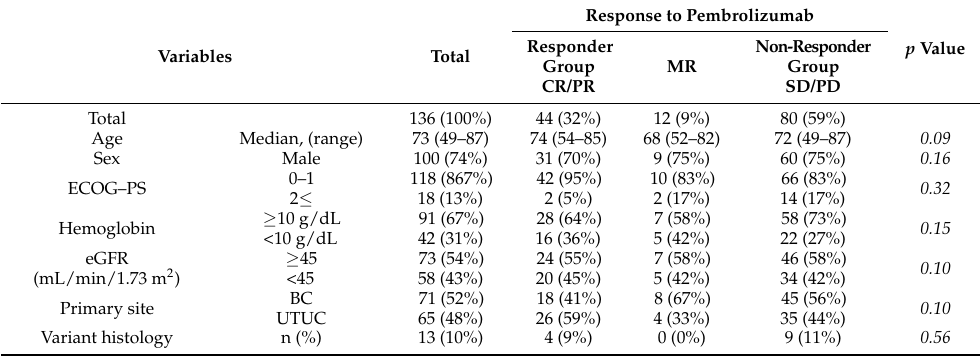
Table 1. Clinicopathological background factors of 136 patients and 3